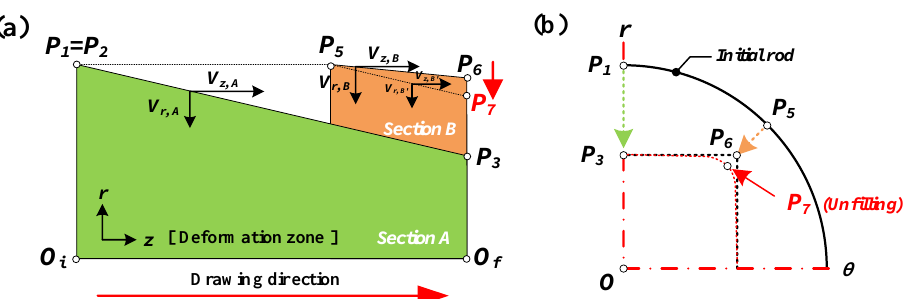
Figure 3. Expected path of metal flow: ( a ) comparison of sections A and B for the shape drawing process and ( b ) metal flow in radial direction.